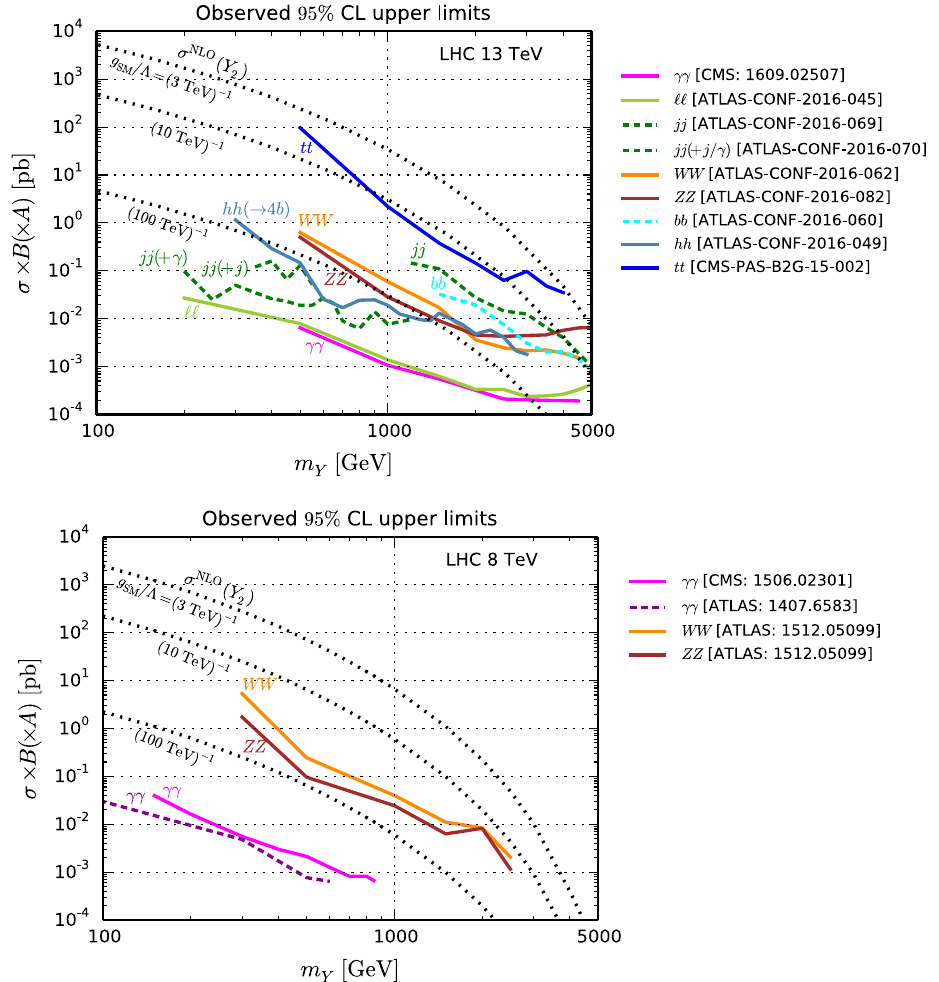
Fig. 12 Observed 95% CL upper limits on resonant production cross section times branching ratio (times acceptance) as a function of the resonance mass from each experimental paper; see Table 2 for more